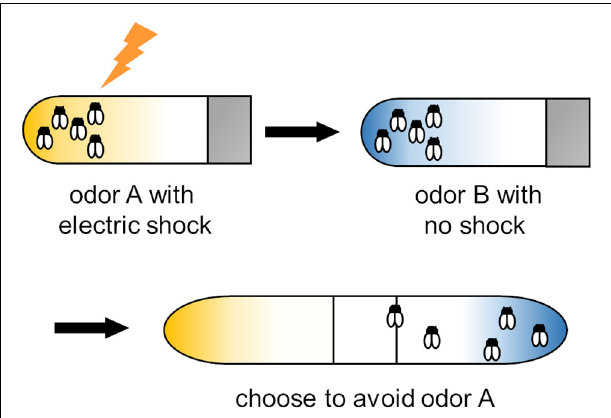
FIGURE 1 | Training protocol for olfactory associative learning in Drosophila . Flies were exposed to odor A with an electric shock and then to odor B with no shock. After training, flies are placed at the choice point of a T maze with odor A or B diffused from both ends. Trained flies avoid the shock-paired odor (i.e., odor